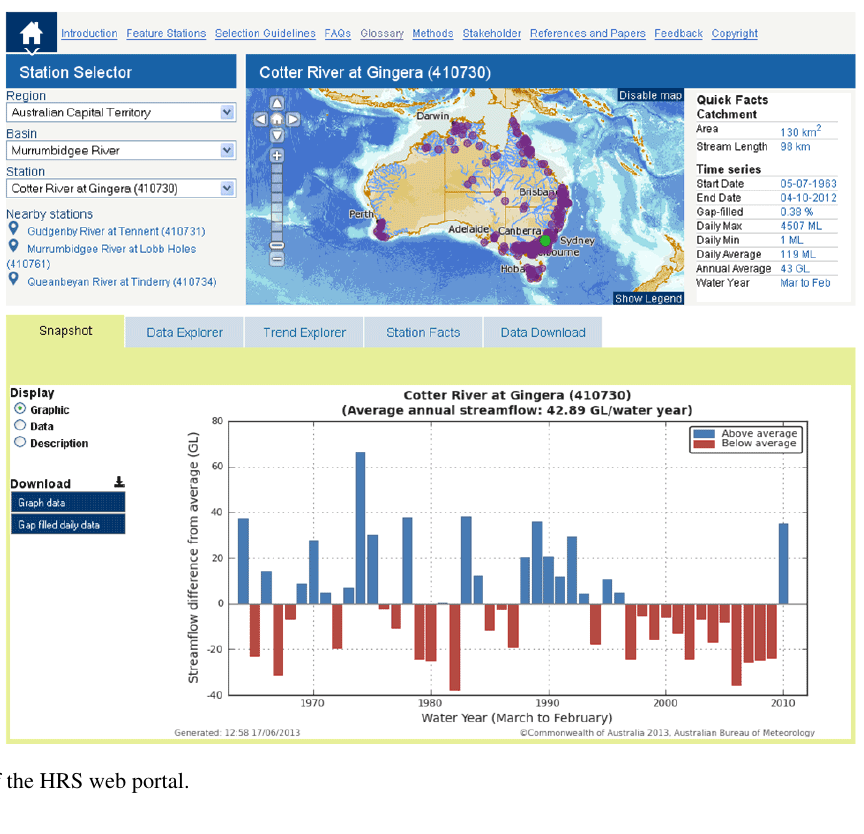
Figure 3. Snapshot of the HRS web portal.